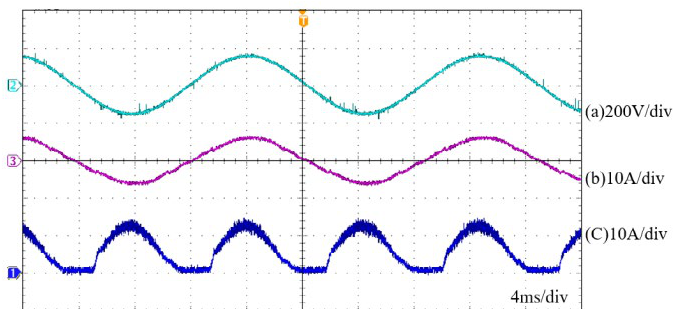
Figure 12. Experimental results of BBI under the steady state, ( a ) power grid voltage, ( b ) output current, ( c ) current of inductor L 1 .